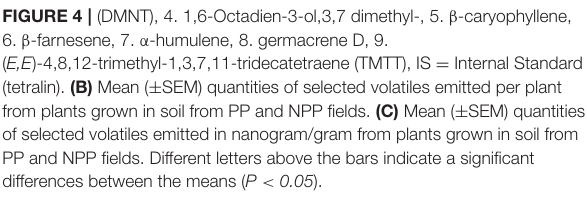
FIGURE 4 | (DMNT), 4. 1,6-Octadien-3-ol,3,7 dimethyl-, 5. β -caryophyllene, 6. β -farnesene, 7. α -humulene, 8. germacrene D, 9. ( E,E )-4,8,12-trimethyl-1,3,7,11-tridecatetraene (TMTT), IS = Internal Standard (tetralin). (B) Mean ( ± SEM) quantities of selected volatiles emitted per plant from plants grown in soil from PP and NPP fields. (C) Mean ( ± SEM) quantities of selected volatiles emitted in nanogram/gram from plants grown in soil from PP and NPP fields. Different letters above the bars indicate a significant differences between the means ( P < 0.05